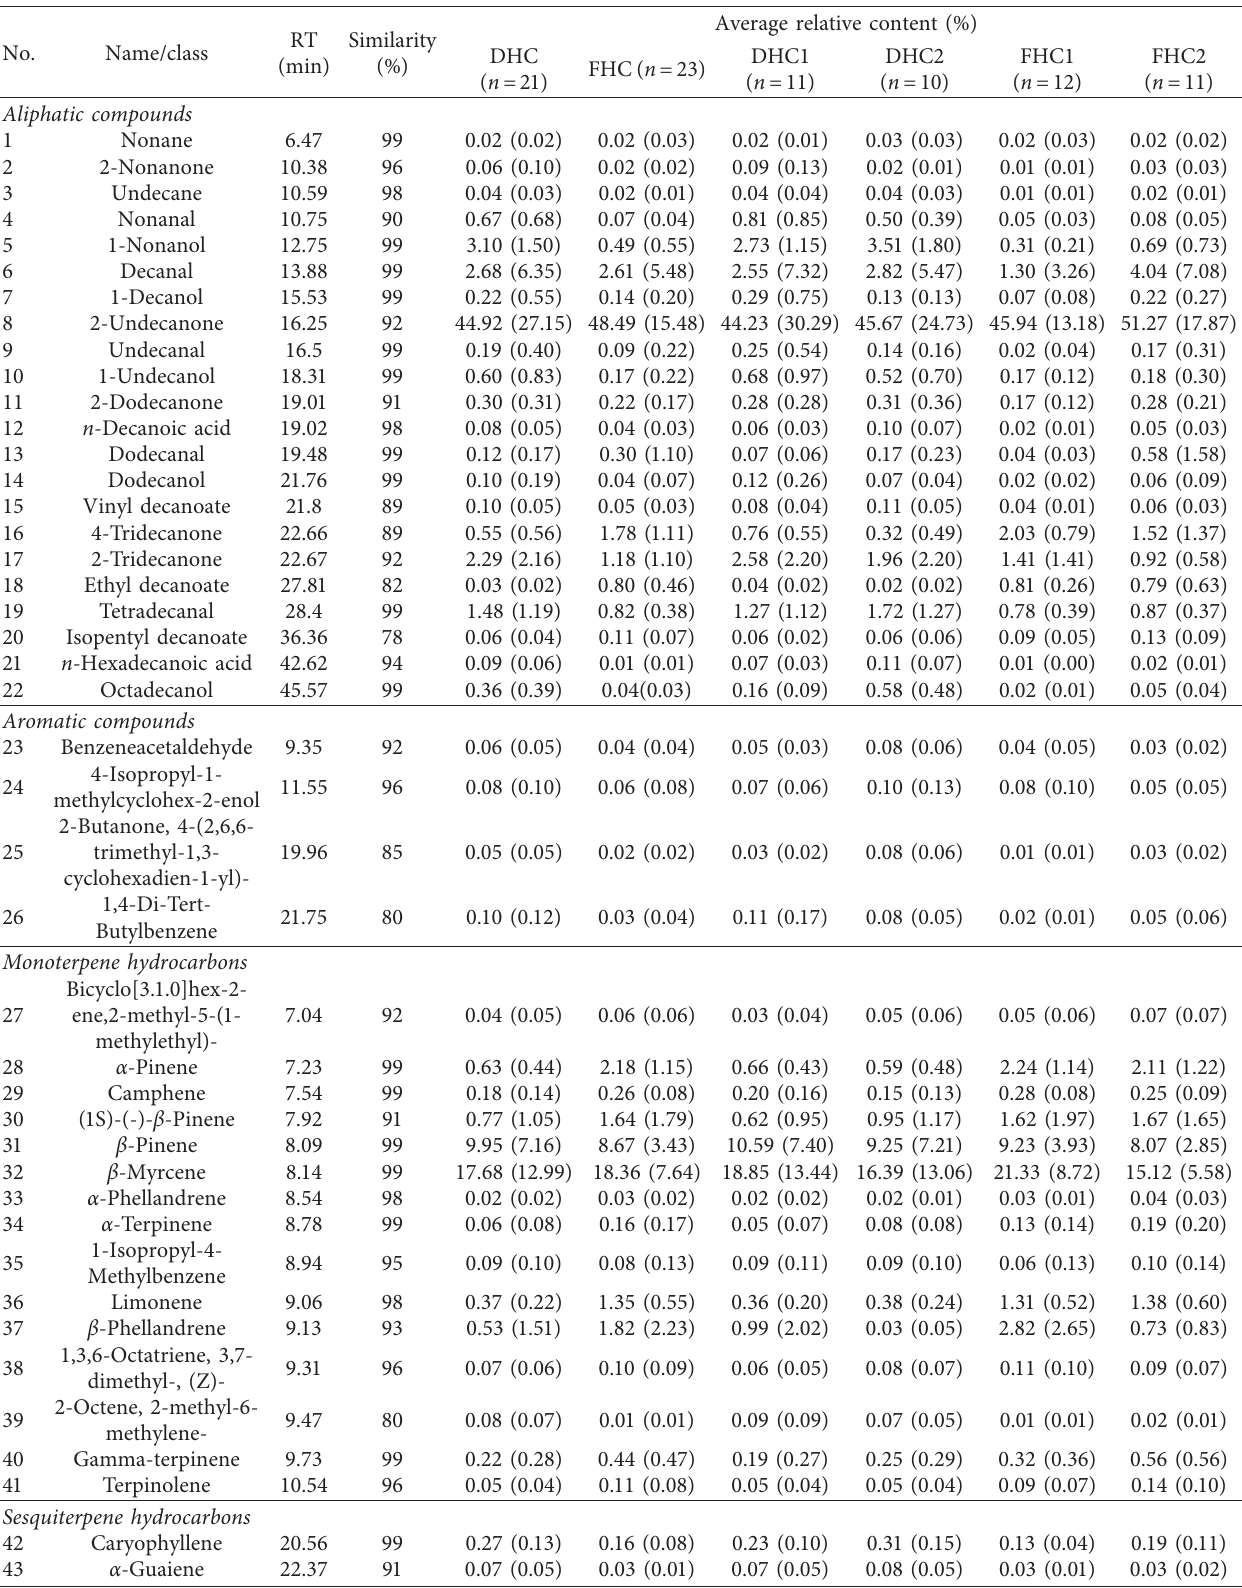
Table 1: Average relative content of sixty-nine common volatile constituents of DHC and FHC at two harvest